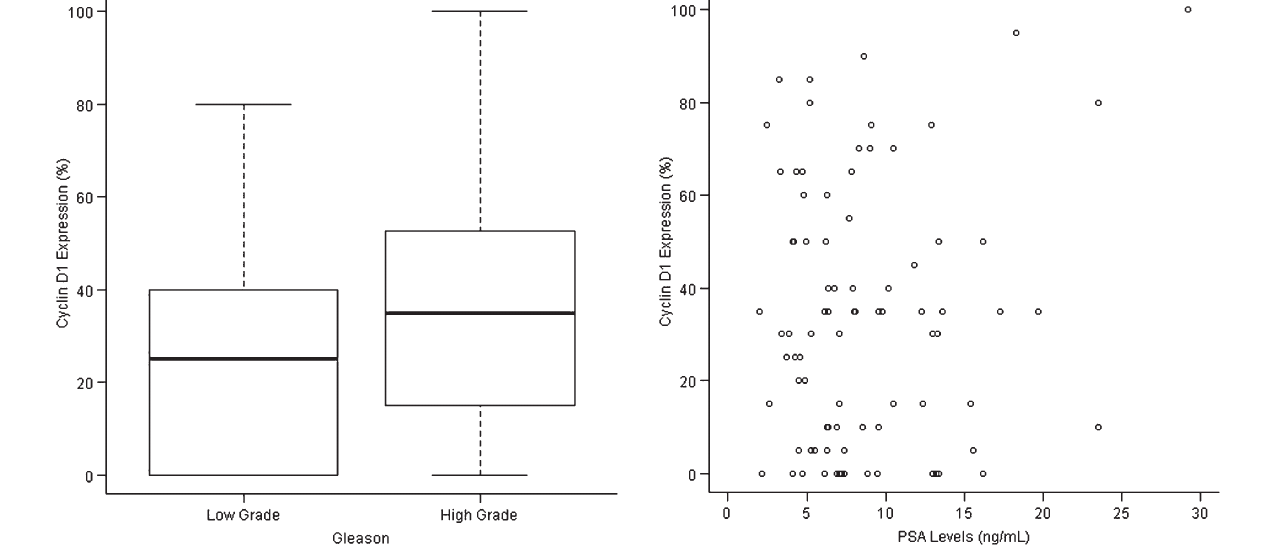
Figure 4. Relationship between cyclin D1 expression and preoperative prostate-specific antigen (PSA)